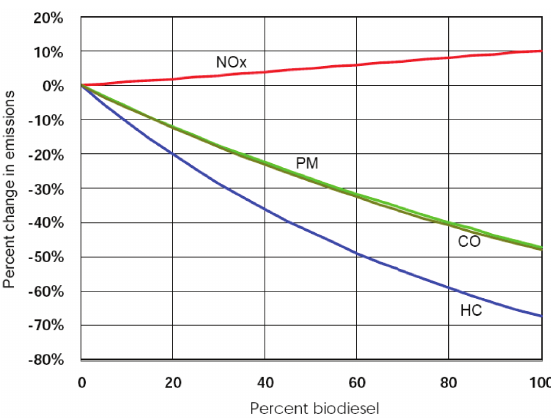
Fig. 1 - Average pollutant emissions at different biodiesel blends in diesel engines (US EPA